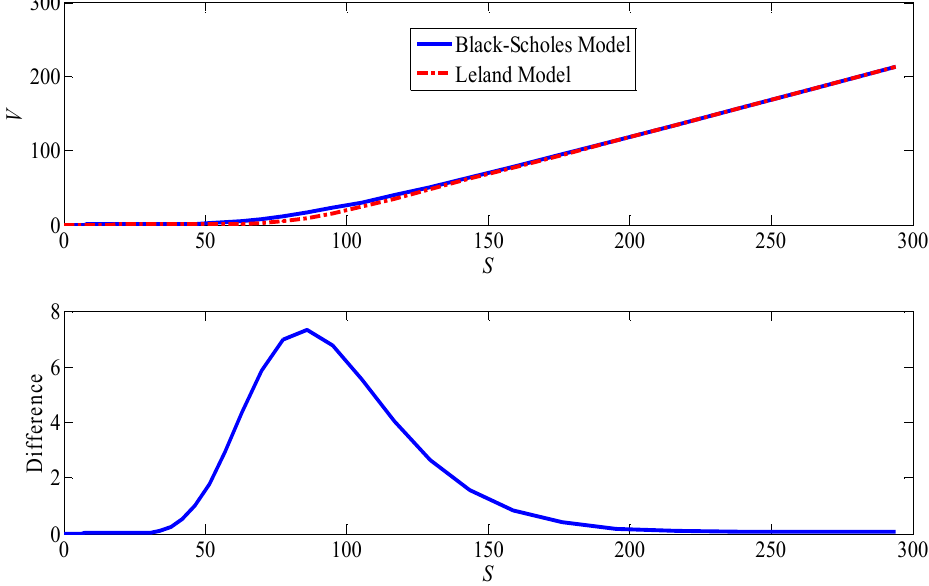
Figure 2. Difference of call option price between Black–Scholes model and Leland model.